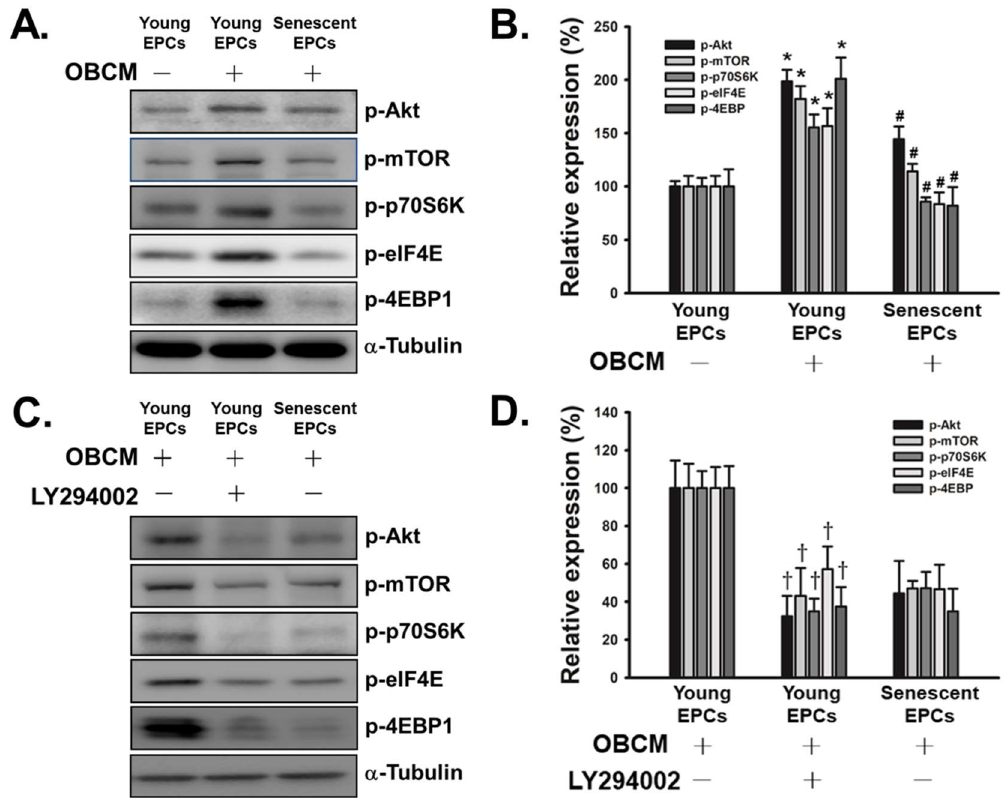
Figure 4. Effect of senescence on osteoblast conditioned medium (OBCM) activated Akt/mTOR translational pathway in EPCs. ( A , B ) Young and senescent EPCs were treated with or without OBCM of MC3T3-E1 cells for 24 h ( N = 5); ( C , D ) Young and senescent EPCs were treated with OBCM in the absence or presence of LY294002 (10 µM) for 24 h ( N = 5). After treatment, cells were harvested and lysed for the detection of p-Akt, p-mTOR, p-p70S6K, p-eIF4E, p-4E-BP1, and α -tubulin by Western blot analysis. The quantitative densitometry of the relative level of signals was performed with Image-Pro Plus. Data are expressed as mean ± S.E.M. of five independent experiments. * p < 0.05 compared with the basal group (without OBCM). # and † p < 0.05 compared with the group of young EPCs.